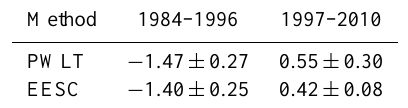
Table 3. The year-round total column ozone trends in DUyr − 1 with 95% confidence intervals estimated from both PWLT and EESC